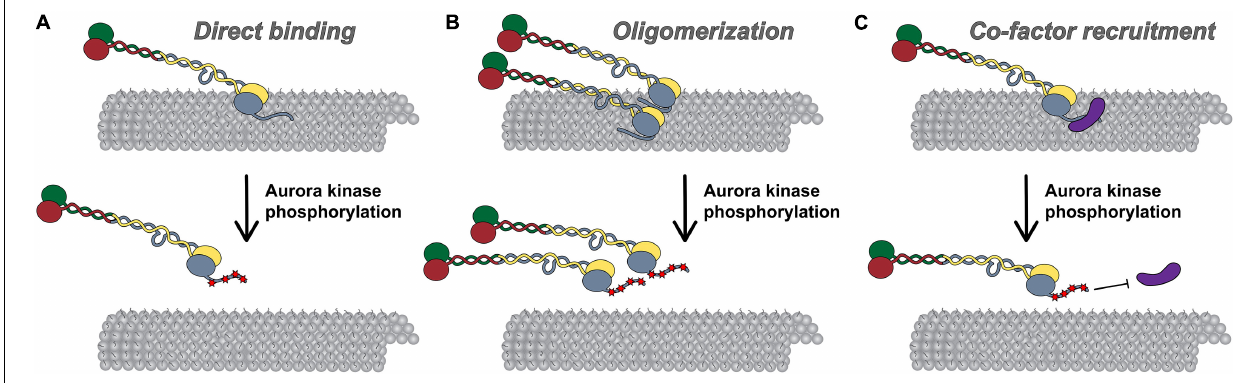
FIGURE 3 | Models for Hec1 tail domain function. (A) Direct microtubule binding. In this model, the tail domain directly interacts with the microtubule lattice to increase CH-domain-mediated NDC80 complex-microtubule interactions. Phosphorylation of the Hec1 tail reduces the positive charge of the tail domain and as a result, reduces the affinity of NDC80 complexes for the negatively charged microtubule lattice. (B) Oligomerization. In this model, a dephosphorylated tail domain functions to oligomerize adjacent NDC80 complexes, which promotes high affinity NDC80-complex-microtubule binding. Upon phosphorylation of the tail domain, complex oligomerization is no longer favored, possibly due to a decrease in affinity of a phosphorylated tail domain for a negatively charged region within the CH domain of Hec1. (C) Co-factor recruitment. In this model, a dephosphorylated Hec1 tail domain recruits kinetochore-associated microtubule binding proteins or protein complexes to promote high affinity NDC80 complex-microtubule binding. In contrast, a phosphorylated tail domain restricts co-factor recruitment. As discussed in the text, these models are not mutually exclusive.